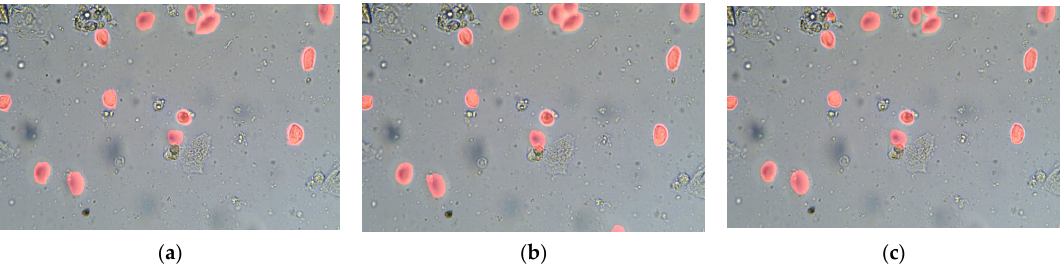
Figure 7. Comparison between the rough detection result and the fine detection result. For convenience of display, we have used red to mark the TV regions on the original image. ( a ) Ground truth of TV; ( b ) rough detection result; ( c ) fine detection result.